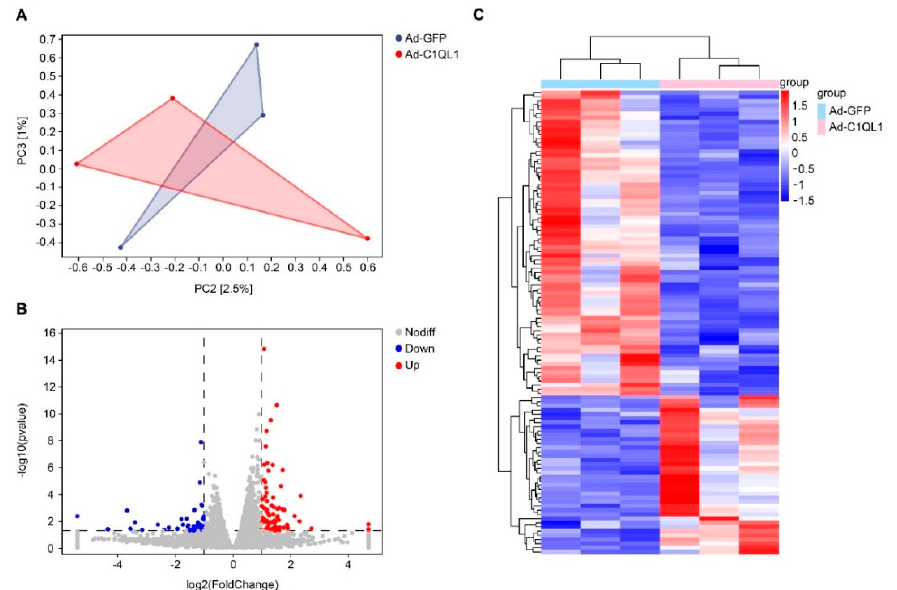
Figure 7. Typical characteristics of DEGs in the aortas of ApoE KO mice. ( A ) Volcano plots show the DEG expression based on RNA sequence analysis. ( B ) Analysis of the DEGs was performed utilizing DESeq software by contrasting the Ad-GFP and Ad-C1QL1 cohorts. ( C ) The expression levels are denoted by colors, red (high expression) and blue (low expression), and are proportional to their brightness (see color bar). n = 3 for each cohort.